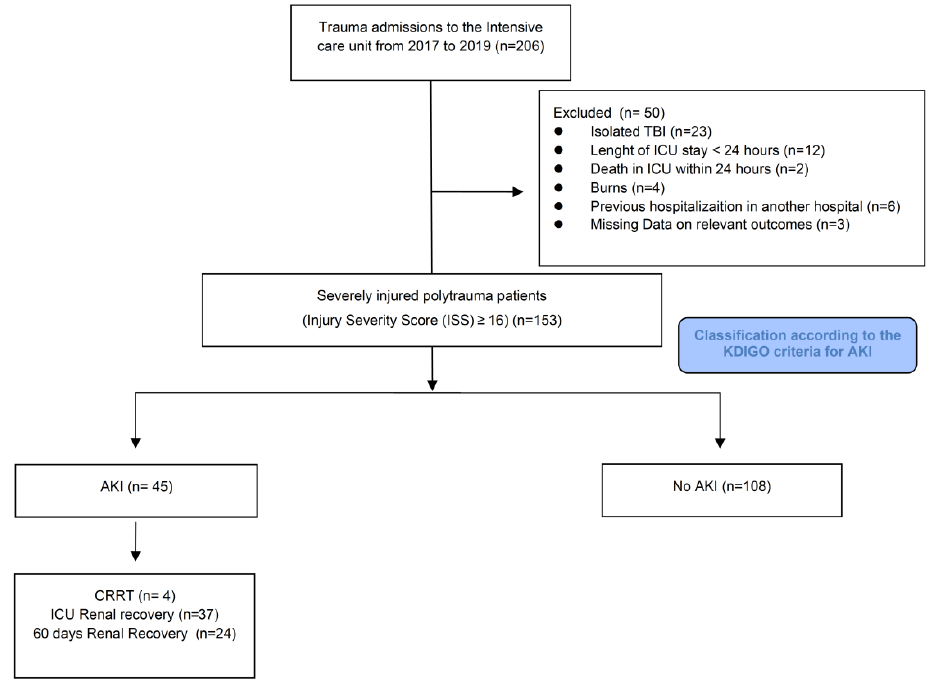
Figure 1. Study Figure 1. Study flowchart. Table 1. Baseline characteristics, comorbidities, medications, and mechanism of injury in the overall population and according to AKI status.